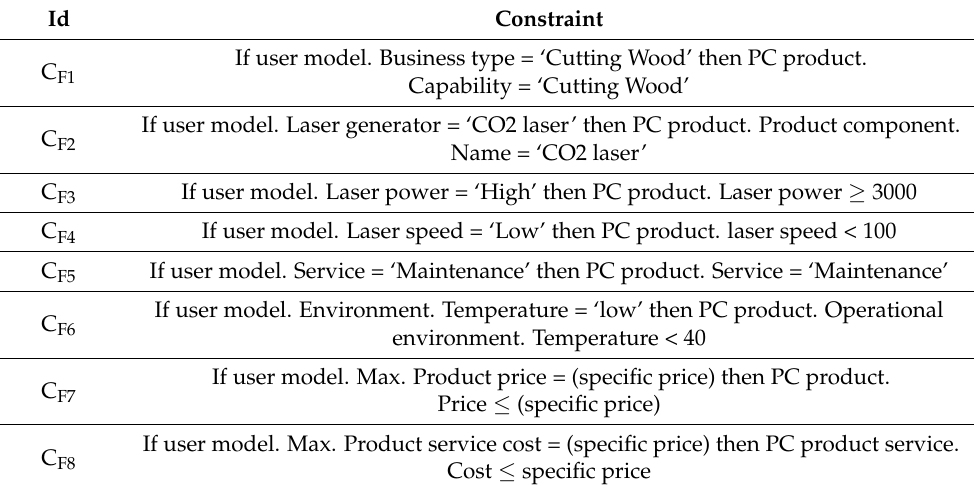
Table 7. Examples of domain filtering constraints.